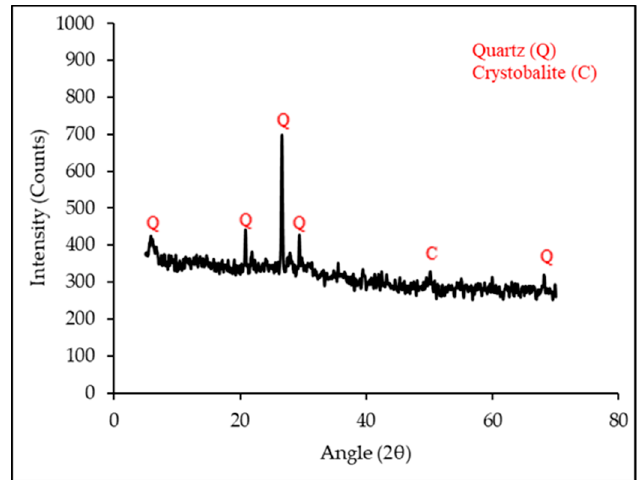
Figure 2. XRD pattern of processed SCBA (sieved and ground for 45 min).